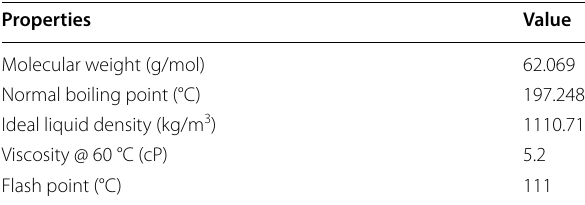
Table 3 Chemical properties of MEG